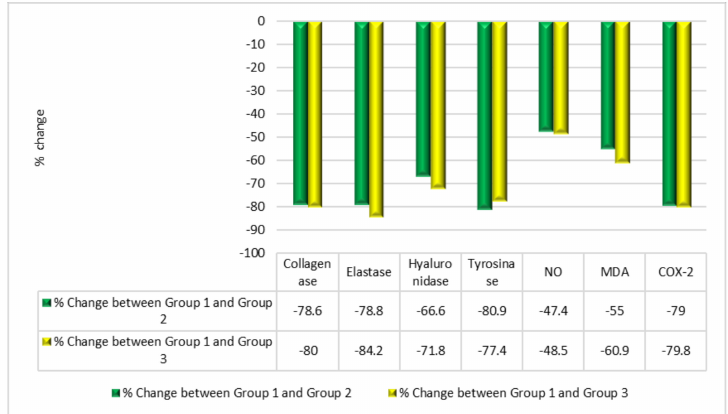
Figure 5. Comparison of beneficial effects of pomegranate seed oil extract (PSOE) and TROSYD treatment in human skin investigations. We compared the changes in the levels of collagenase, elastase, hyaluronidase, tyrosinase, nitric oxide (NO), malondialdehyde (MDA), and cyclooxygenase 2 (COX-2) between Group 1 and Group 2 to the changes between Group 1 and Group 3. Group 1 received no skin treatment (for at least 2–3 months); Group 2 was administered 250 mL/kg PSOE treatment; Group 3 was administered 250 mg/kg TROSYD for 21 days by a dermatologist. We administered the treatments directly to the inflamed part of the skin once per day for 21 days of